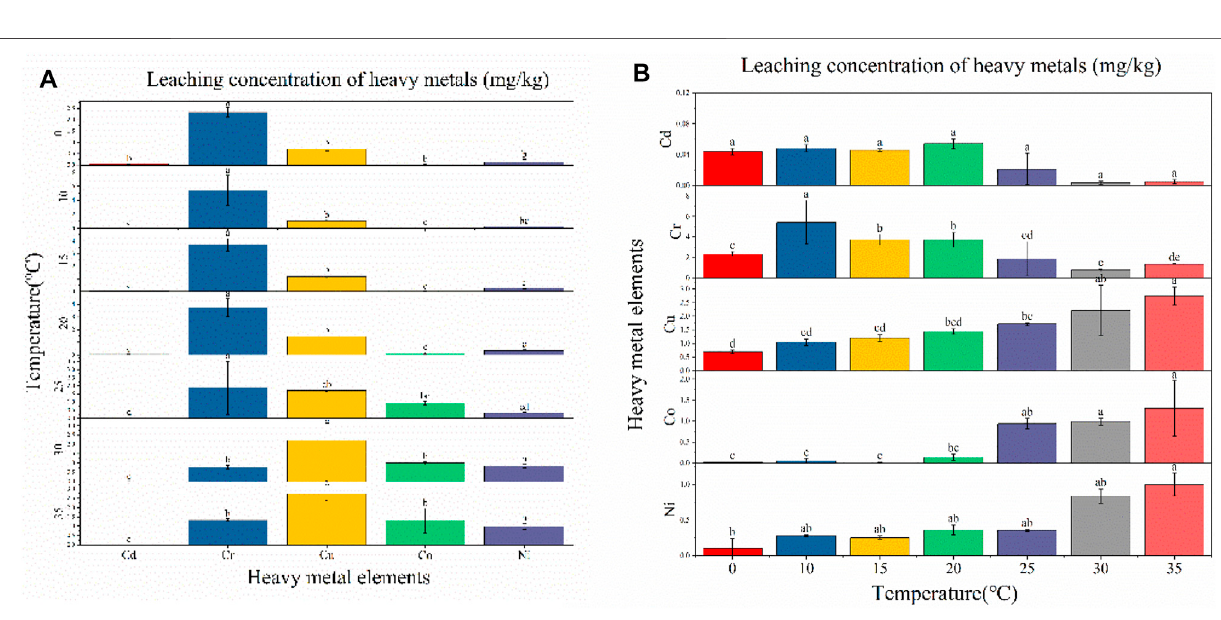
FIGURE 5 | Leaching concentration of heavy metals at different temperature conditions: (A) difference analysis of different heavy-metal element leaching concentrations under the same temperature condition; (B) difference analysis of different temperature leaching concentrations under the same heavy-metal element